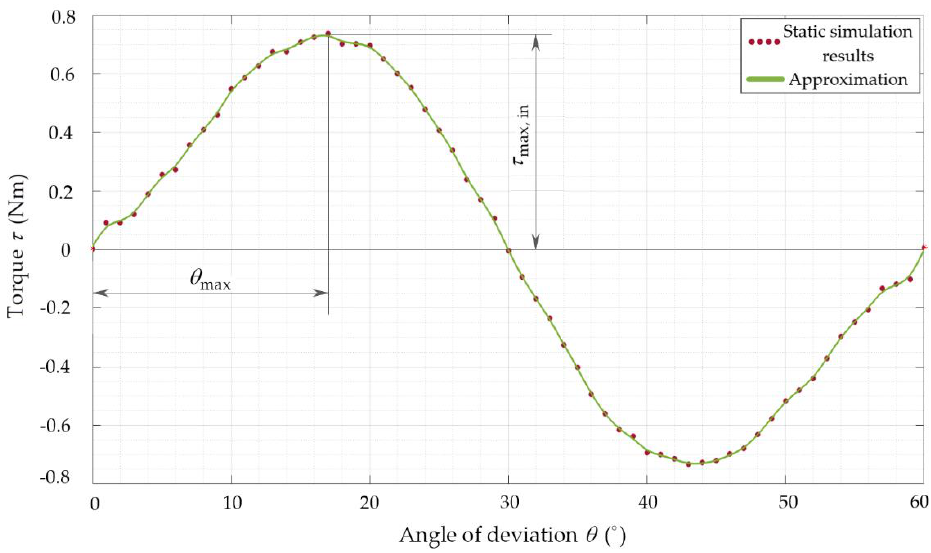
Figure 2. Magnetic torque versus angle of deviation of the initial design of the coupling.